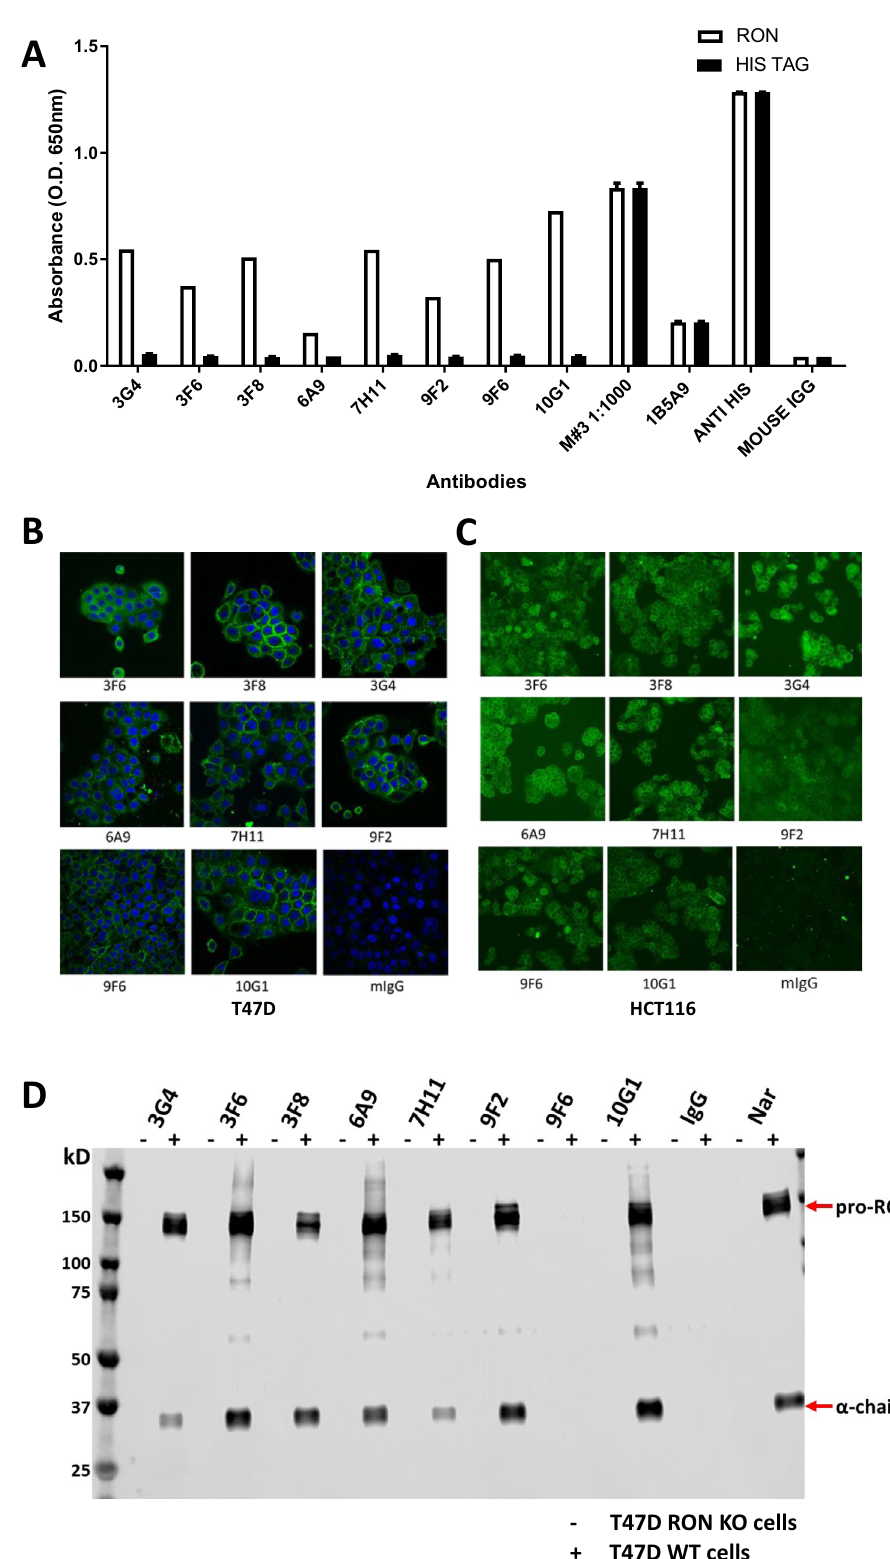
Figure 1. Screening and characterisation of RON antibodies via ELISA, cell staining, immunoprecipitation and flow